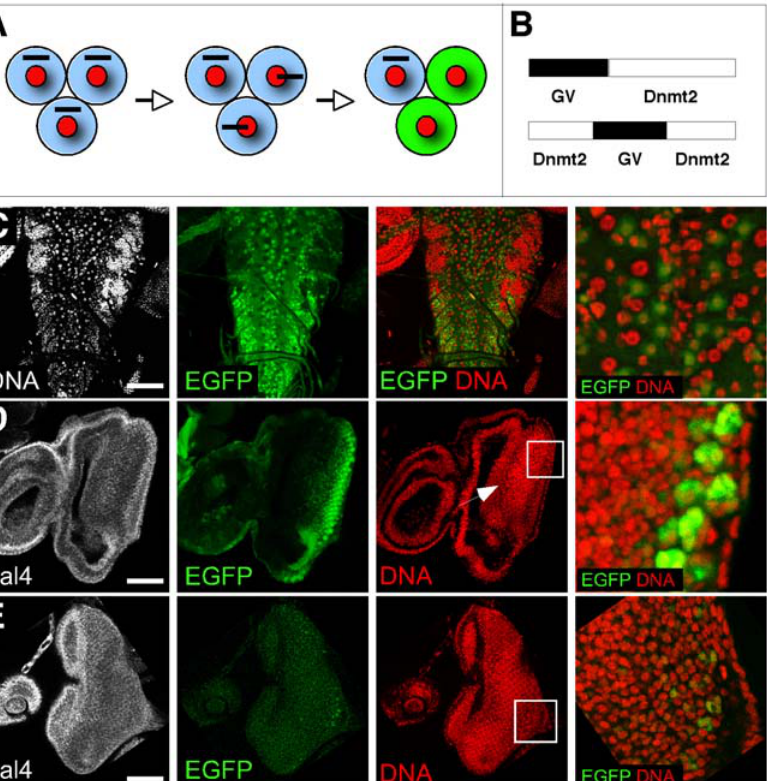
Figure 6. Nuclear access reporter assay using GAL4:VP16-Dnmt2 fusion proteins. (A) Schematic representation of the nuclear access reporter assay. Ubiquitous expression of the GAL4:VP16 (GV) fusion proteins (black bar) causes the expression of EGFP only in some cells (green) due to selective nuclear access of the fusion protein. (B) GV-fusion proteins. GV-Dnmt2 (upper panel), Dnmt2-GV-Dnmt2 fusion expressing GV in the context of a split Dnmt2 protein (lower panel) which served as control. (C) GAL4:VP16-Dnmt2 expression in third instar larval brains causes widespread UAS-EGFP expression in the ventral ganglion. The magnification shows that regularly spaced cells (neuroblasts) express EGFP (green). (D) Ubiquitous GAL4:VP16-Dnmt2 in third instar larval eye discs causes specific UAS-EGFP expression behind the morphogentic furrow (arrow). Magnification of a field of cells shows robust expression in differentiated photoreceptor cells. (E) The control construct (GAL4:VP16 in a split Dnmt2 protein) causes background levels of UAS-EGFP expression. GAL4 (gray), EGFP (green), DNA (red). Scale bars: (C) 100 m m; (D, E) 70 m m.